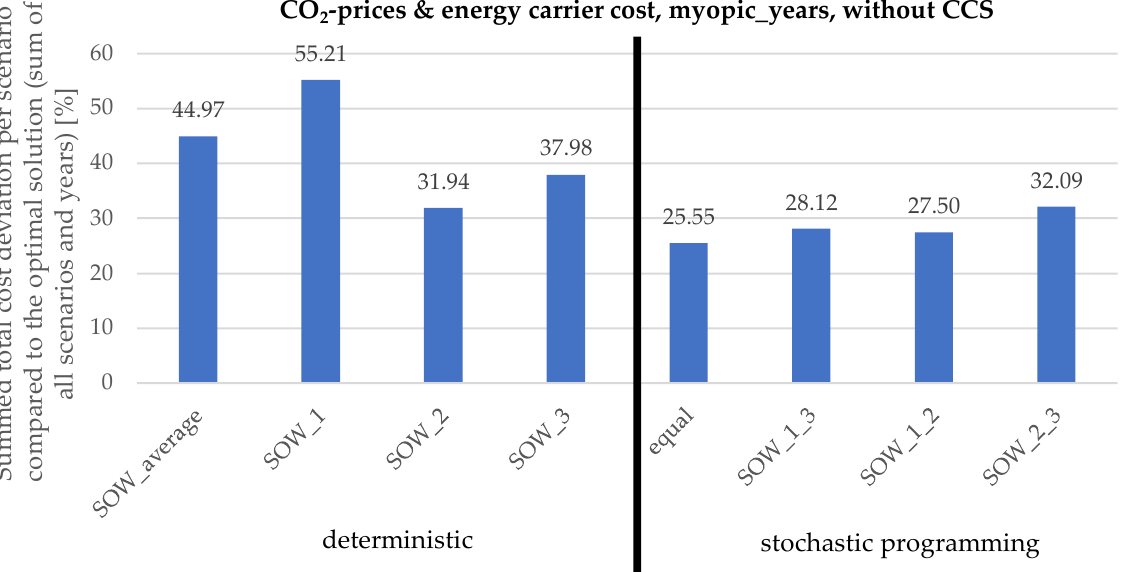
Figure 22. STCD per scenario for uncertain CO 2 prices and energy carrier cost (myopic_years, without CCS).